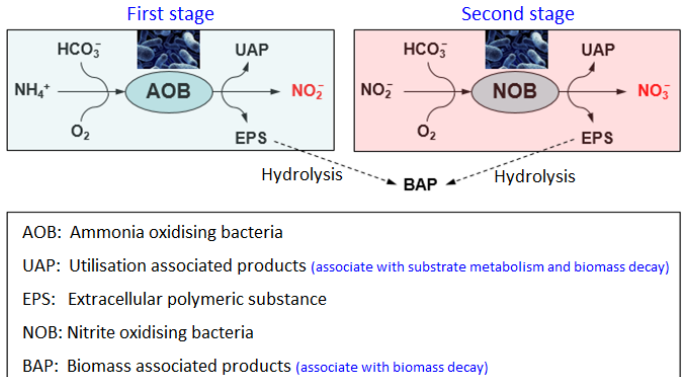
Figure 1. Microbiological process involved in nitrification (based in part on Ni et al. [24], Copyright 2011,